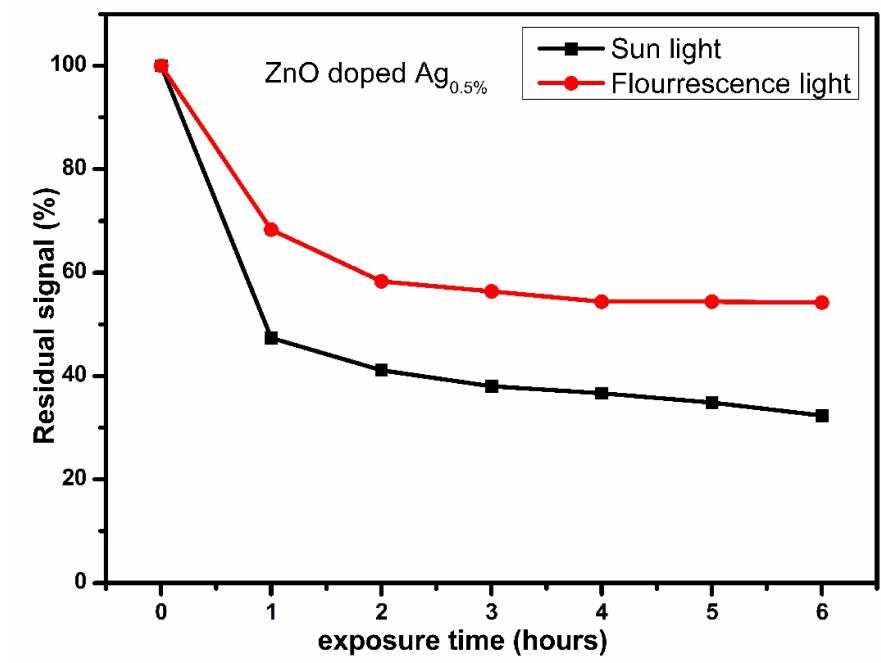
Figure 16. The optical fading of Ag-doped ZnO thin films exposed to sunlight and fluorescent light.